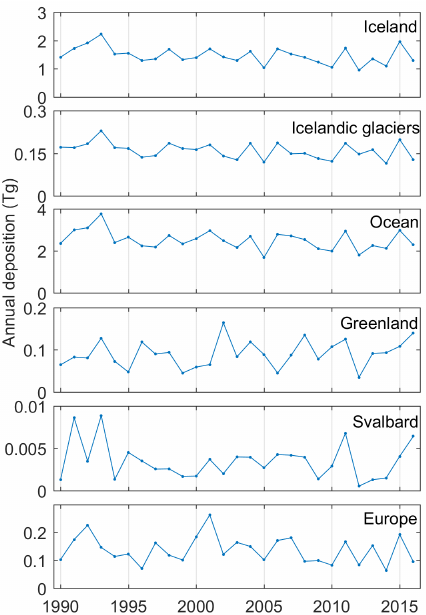
Figure 12. Time series (1990–2016) of modelled dust deposition (Tgyr − 1 ) in specific regions. Note that Iceland also includes depo- sition on Icelandic